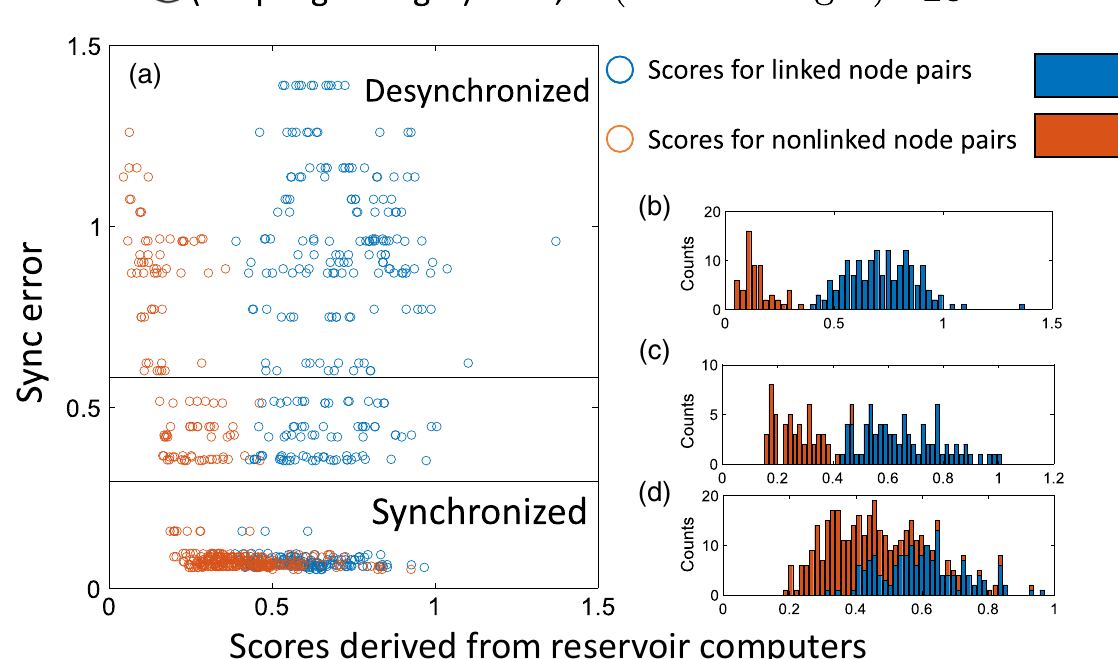
FIG. 8. This figure shows statistics of our results for the link scores S i;j of all the possible networks (listed in Fig. 4) with ϵ ¼ 0 . 6 and κ ¼ 10 − 3 , where, in determining the statistics, for each of the networks, we use a single random realization of the initial condition and reservoir couplings. In (a), for each individual directed node pair ð i; j Þ , i.e., each candidate link, a point is plotted in the sync-error or score plane with true links plotted in blue and link absences denoted in red, with red overlaying blue. The two black horizontal lines divide the sync-error or score plane into three regions corresponding to networks that are highly desynchronized, moderately synchronized, and strongly synchronized. (b) – (d) show histograms of the node scores for each of the three levels of network synchronization demarcated in (a). Bins with scores that all correspond to true links (absence of links) are colored blue (red). Bins with scores corresponding to both true links and link absence are vertically stacked into upper and lower pieces, where the lower piece (blue) corresponds to the number of true links in the bin and the upper piece (red) corresponds to the number of missing